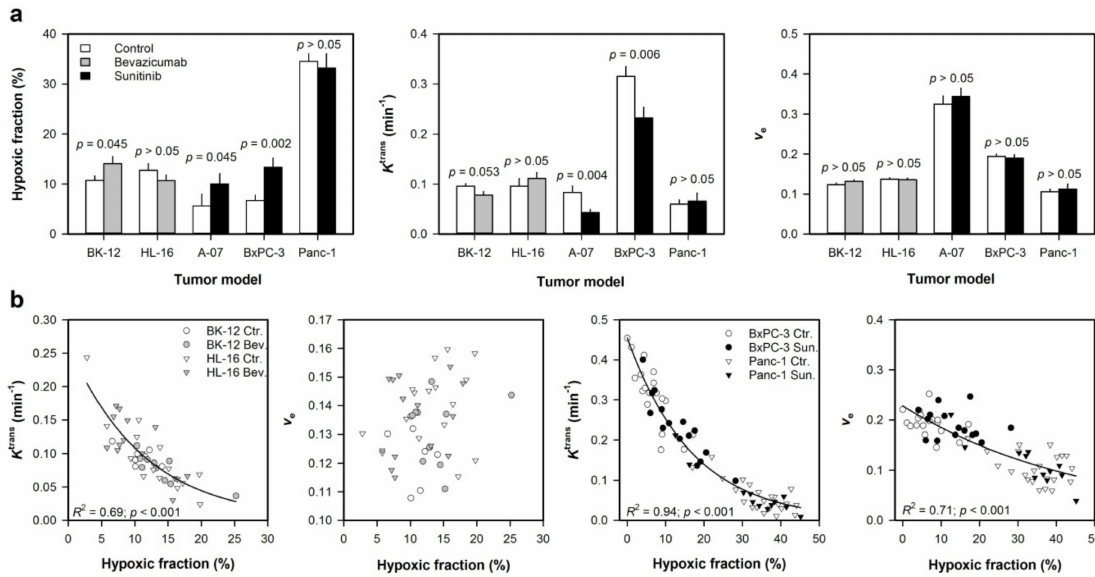
Figure 6. Tumors were subjected to DCE-MRI and measurement of hypoxic fraction after antiangiogenic treatment. Tumor-bearing mice were given 3 doses of 10 mg / kg bevacizumab over a period of 8 days (BK-12 and HL-16 cervical carcinoma xenografts), or daily doses of 40 mg / kg sunitinib for 4 days (A-07 melanoma and BxPC-3 and Panc-1 PDAC xenografts). ( a ) Hypoxic fraction, K trans , and v e in untreated (control) and treated tumors. ( b ) Median K trans versus hypoxic fraction and median v e versus hypoxic fraction in untreated and treated tumors. Hypoxic fractions were measured in histological preparations by using pimonidazole as a hypoxia marker. Columns represent mean of 9–22 tumors and bars represent SEM ( a ). Points represent individual tumors, and exponential curves were fitted to the data by regression analysis ( b ). p -values were obtained by Student’s t -test ( a ) or Pearson product moment correlation test ( b ). Modified from Hauge et al. [42], Gaustad et al. [43], and Wegner et al.